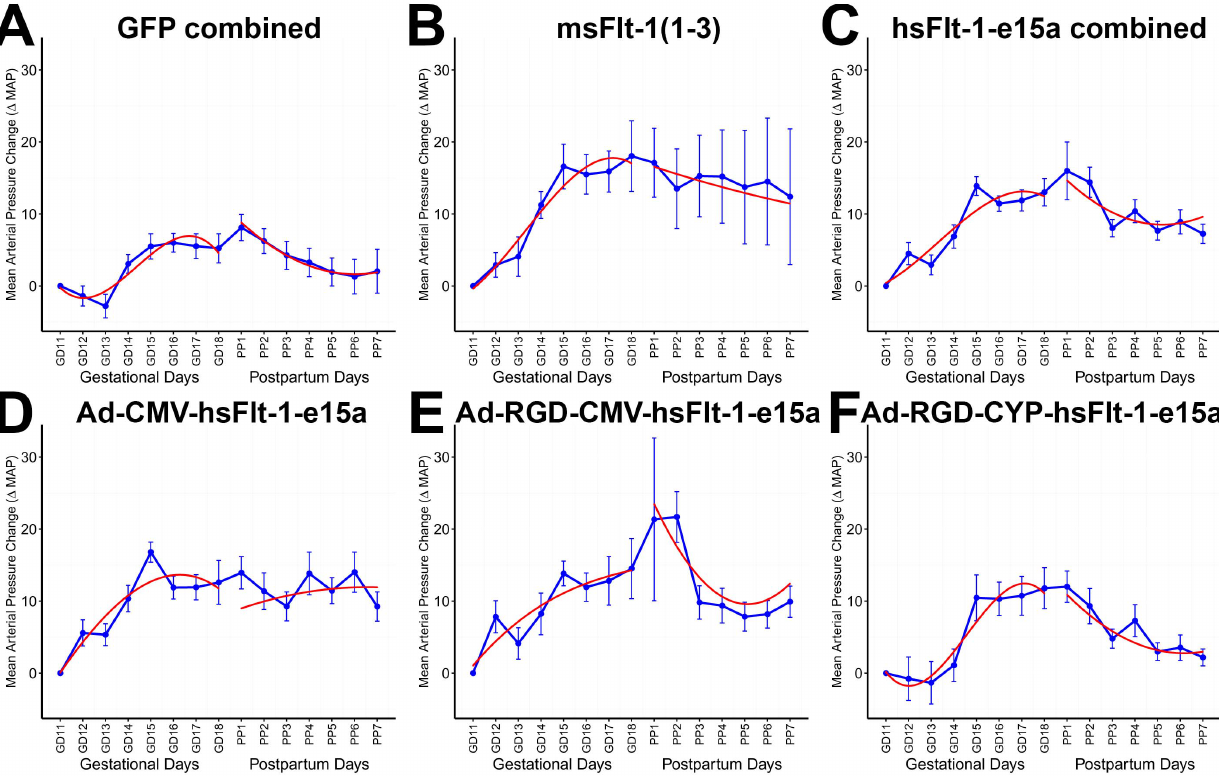
Figure 5. Blood pressure monitoring. X-axes show gestational days (GDs) and postpartum days (PPDs). Mean arterial pressure changes ( D MAP) are depicted with blue curves. Blue lines show + / 2 standard errors. Red curves depict the D MAP patterns, fitted from the linear mixed effects model. ( A,B ) The blood pressure profile over gestation was different in msFlt-1(1-3)-treated mice from that in GFP-treated mice prior to cesarean delivery (p=3.7 6 10 2 5 ; D MAP at parturition: 12.8 mmHg, p=0.005). ( A,C ) The blood pressure profile over gestation in hsFlt-1-e15a-treated mice (all subgroups combined) was different from that in GFP-treated controls prior cesarean delivery (p=4.3 6 10 2 4 ; D MAP at parturition: 7.8 mmHg, p=0.009). ( D–F ) Among the three sub-groups of hsFlt-1-e15a-treated mice, those that received Ad-CMV-hsFlt-1-e15a and Ad-RGD-CMV-hsFlt-1-e15a had the highest increase in D MAP on GD15 (Ad-CMV-hsFlt-1-e15a: 11.3 mmHg, p=0.0007; Ad-RGD-CMV-hsFlt-1-e15a: 8.3 mmHg, p=0.009) and on GD18 (Ad-CMV-hsFlt-1-e15a: 7.4 mmHg, p=0.09; Ad-RGD-CMV-hsFlt-1-e15a: 9.3 mmHg, p=0.04) compared to controls. The blood pressure